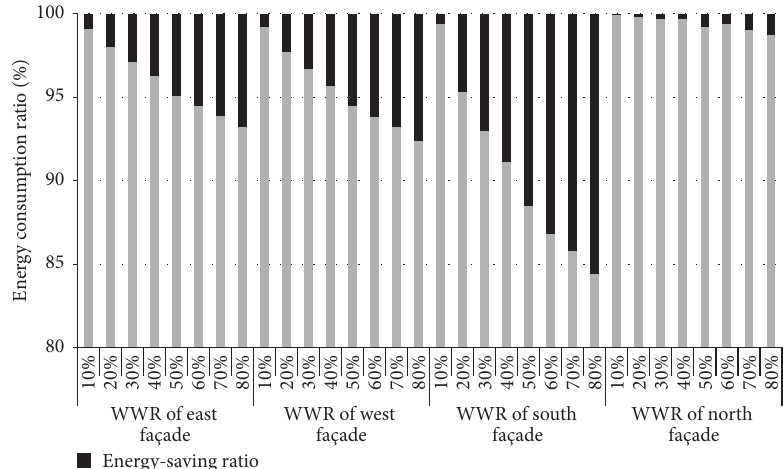
Figure 9: Energy consumption saving rate by Case 3.